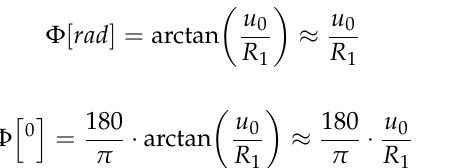
u of the point 0